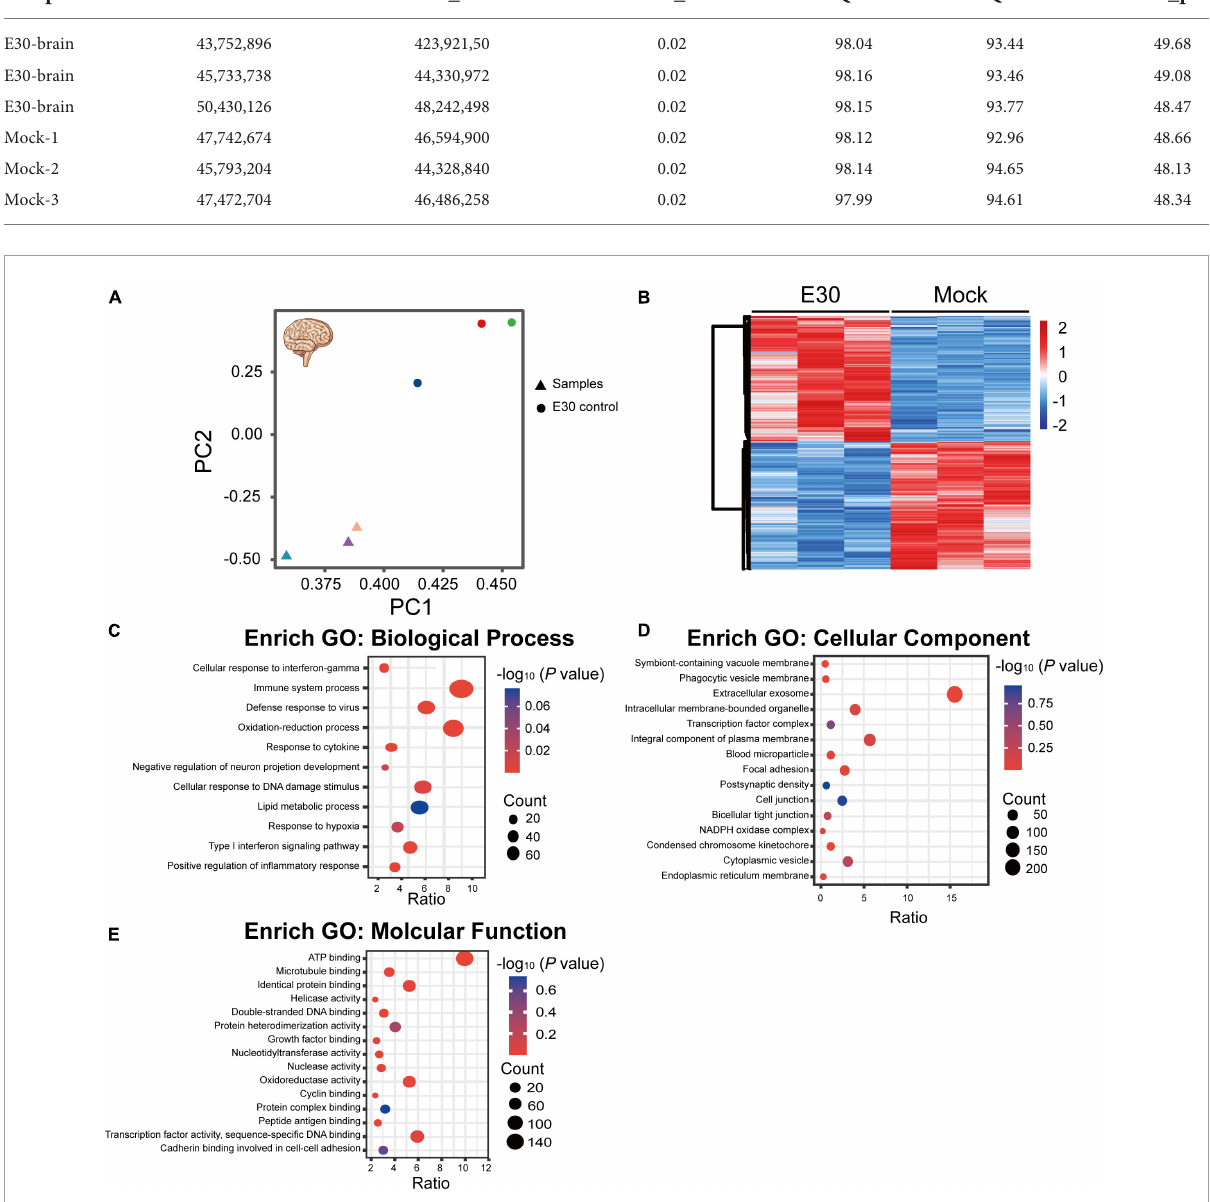
FIGURE4 Functional classification of differentially expressed genes (DEGs) in E30-infected suckling mice brain tissue. (A,B) Principal component analysis (PCA) and heat map analysis of E30-infected brain tissue and control infection group (each group, n = 3), (C) enriched pathways among DEGs in biological processes, (D) cellular components, and (E) molecular function terms. High P -values are in blue and low P -values are in red. The size of the spots indicates the number of genes.